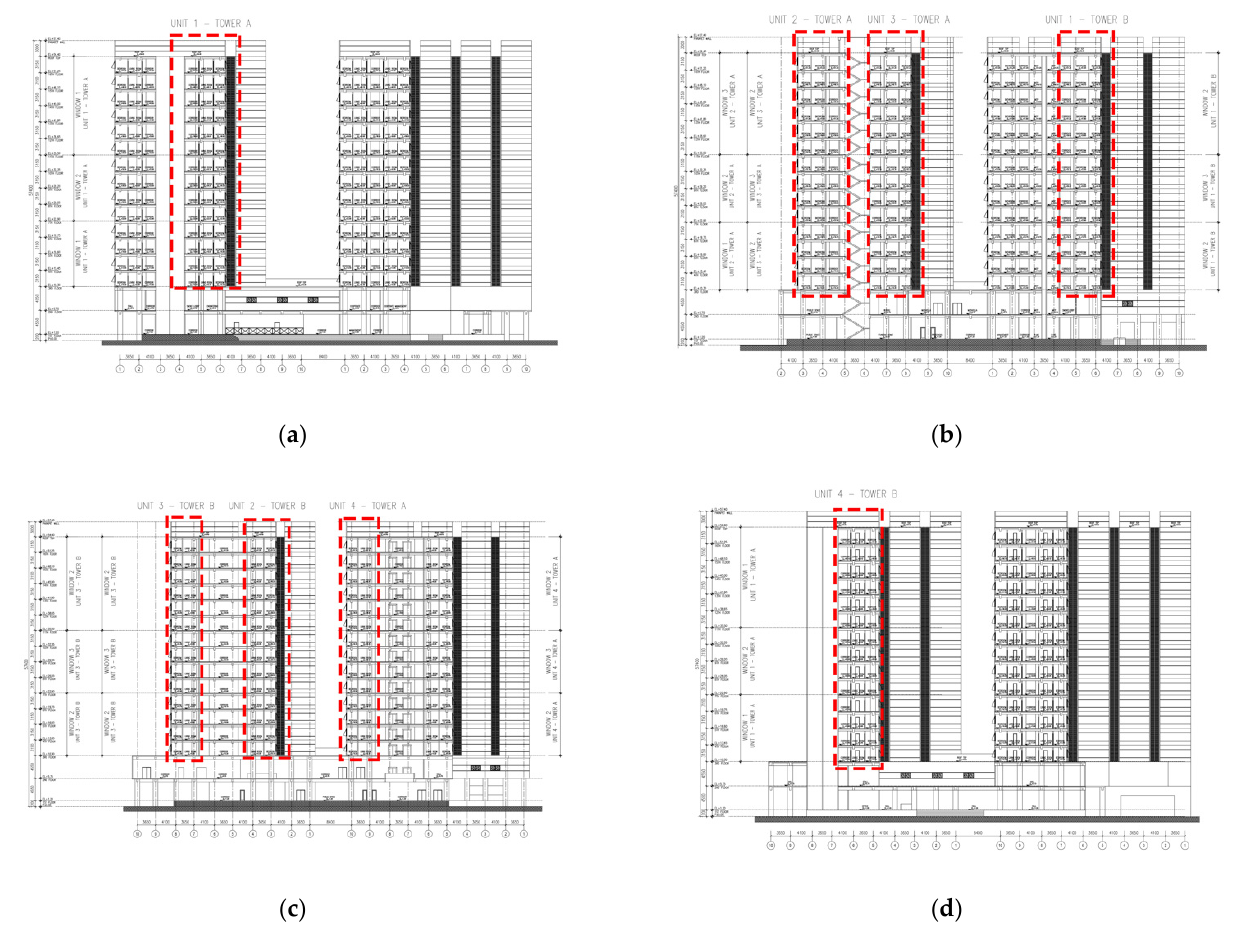
Figure 14. The vertical mapping of the window dimension: ( a ) Unit 1 in tower A; ( b ) Unit 2, 3 in tower A and unit 1 in tower B; ( c ) unit 3 in tower B, unit 2 in tower B, and unit 4 in tower A; ( d ) unit 4 in tower B.